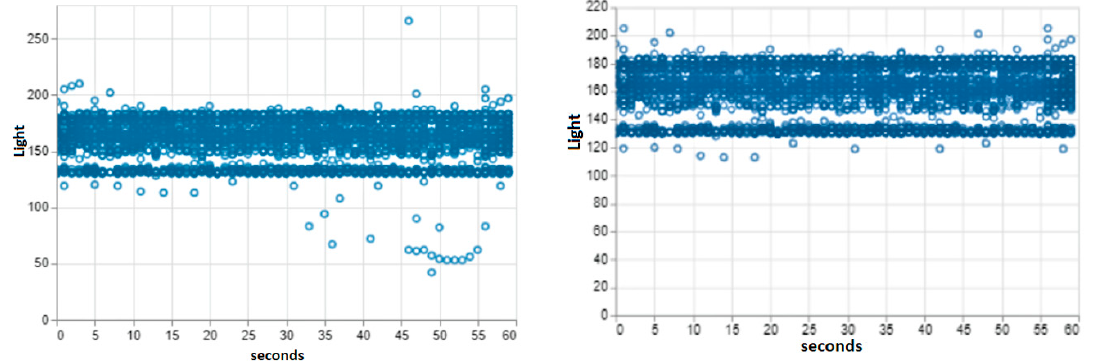
Figure4. Figure 4. Scatterplot of the default experimental dataset before (left) and after (right) data pre- processing.